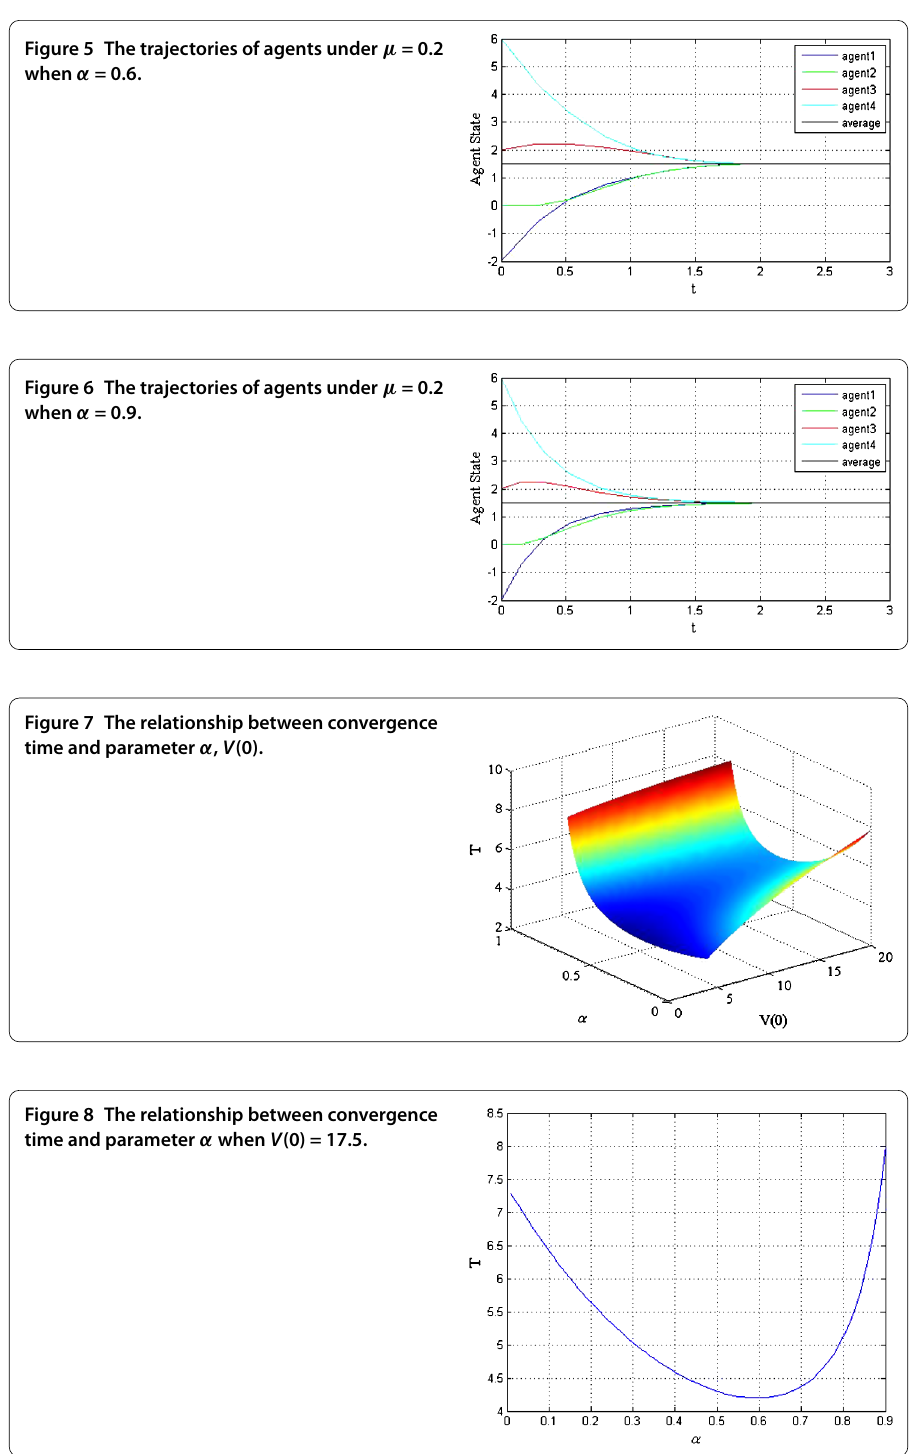
Figure 5 The trajectories of agents under μ = 0.2 when α = 0.6.